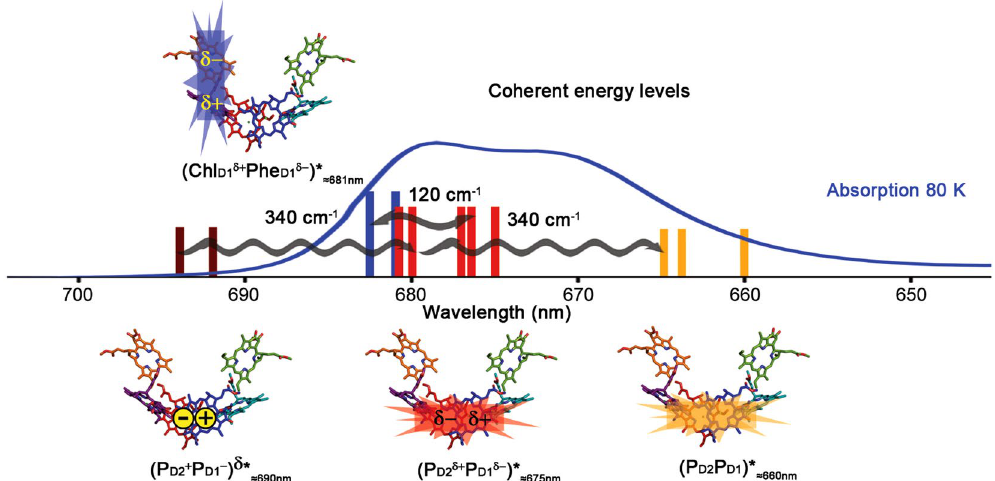
Figure 1. PSII RC X-ray structure, electronic states involved in charge separation and absorption spectrum at 80 K. The energy of the electronic states capable of initiating charge separation are shown as vertical lines on the absorption spectrum at 80 K (blue line) (the different lines for each state correspond to a different realization of the disorder). Only the coherences discussed in the text are shown for clarity. The cofactor participation in each electronic state and its electronic distribution is shown on top of the X-ray crystal structure of the PSII RC (cofactor arrangement adapted from ref. 3): stars and rectangles represent exciton and CT character, respectively. Color code: (P D2 P D1 ⁎ + ) ≈ 660nm (orange), (P D2 δ+ P D1 δ− ⁎ − ) ≈ 675nm (red), (P D2 + P D1 − ) δ ≈ 690nm (dark red) and (Chl D1 δ+ Phe D1 δ− ⁎ − ) ≈ 681nm (blue). Cofactors colour code: P D1 (red), P D2 (blue), Chl D1 (purple), Chl D2 (cyan), Phe D1 (orange), Phe D2 (green). The horizontal wiggled arrows represent the discussed coherences between electronic states observed as cross-peaks in the 120 and 340 cm − 1 time-resolved 2D frequency maps. This figure has been adapted from ref.